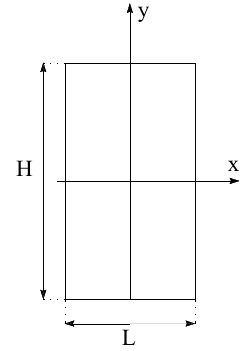
Figure 1. The rectangular enclosure under investigation.